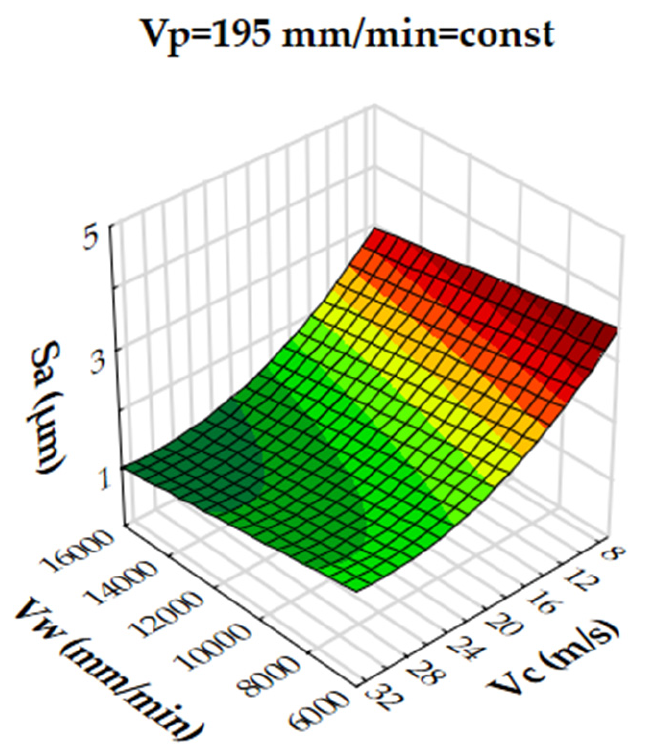
Figure 11. Dependence of roughness, Sa, on longitudinal feed speed, Vw, and cutting speed, Vc, for a conventional grinding wheel (constant Vp).